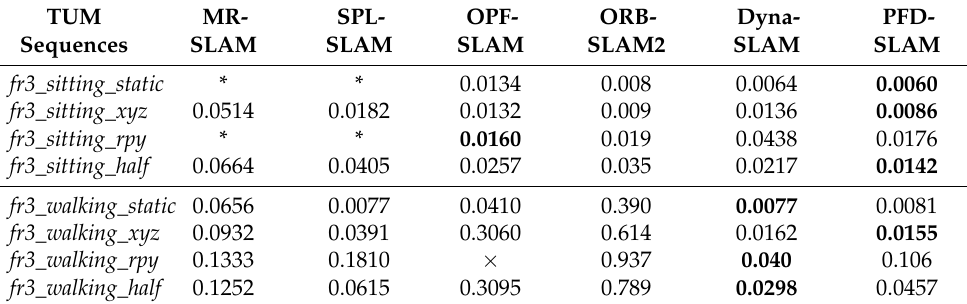
Table 2. Comparisons of ATE-RMSE (m) on the TUM